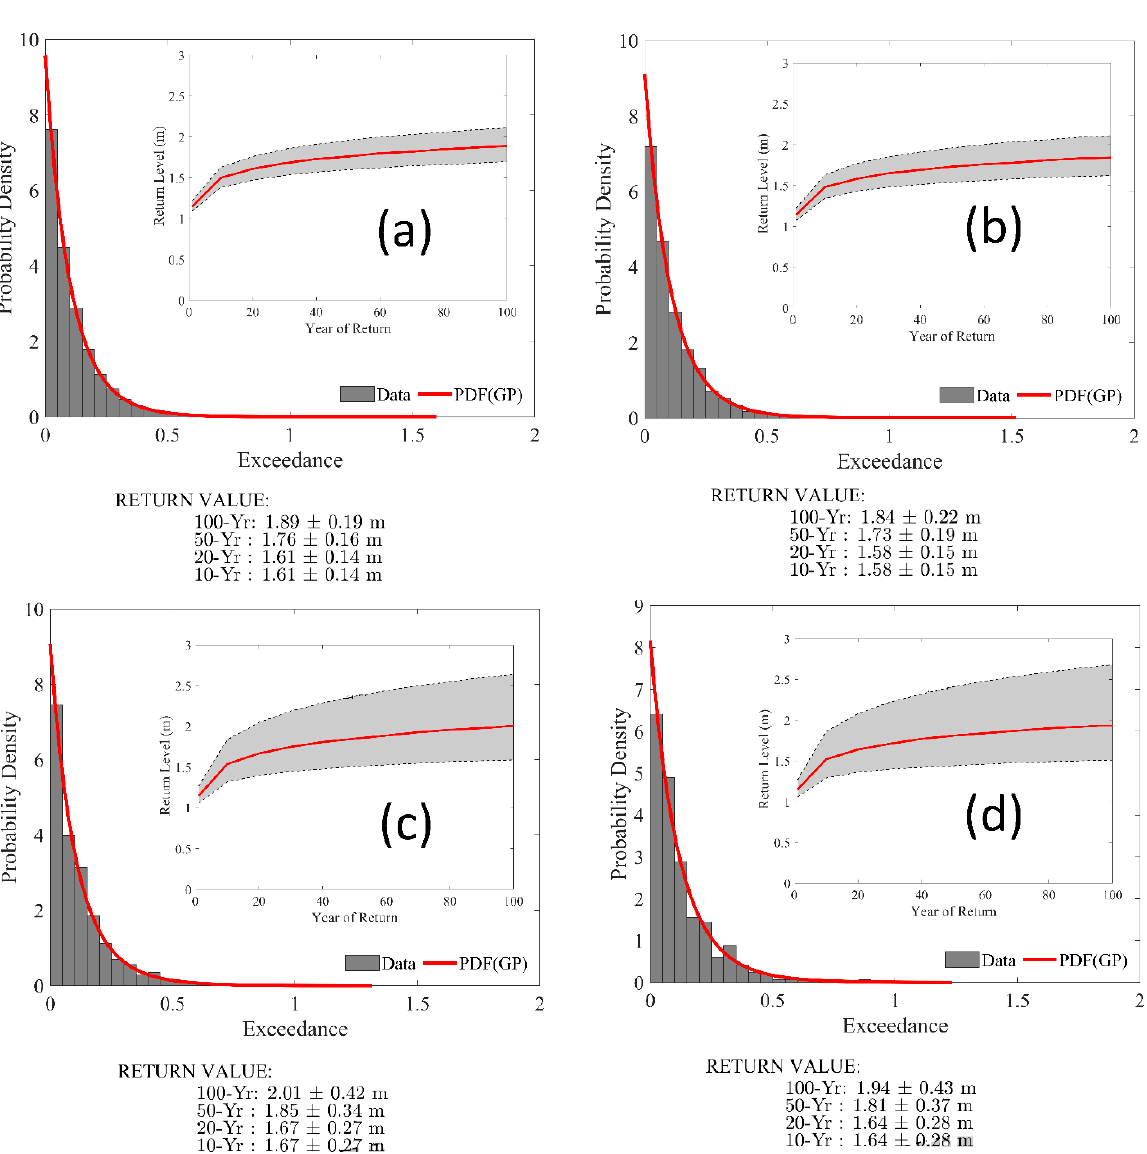
Figure A1. Estimated return values of SWH with 95th confident intervals and histograms of tail data at Sandringham for different threshold levels: ( a )—90th percentile; ( b )—95th percentile; ( c )—99th percentile; ( d )—99.5th percentile.